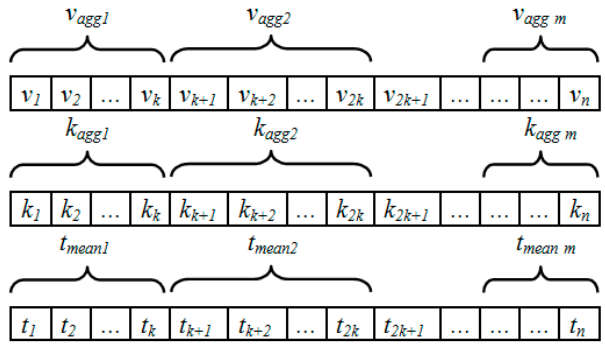
Figure 3. Measured signals aggregation.